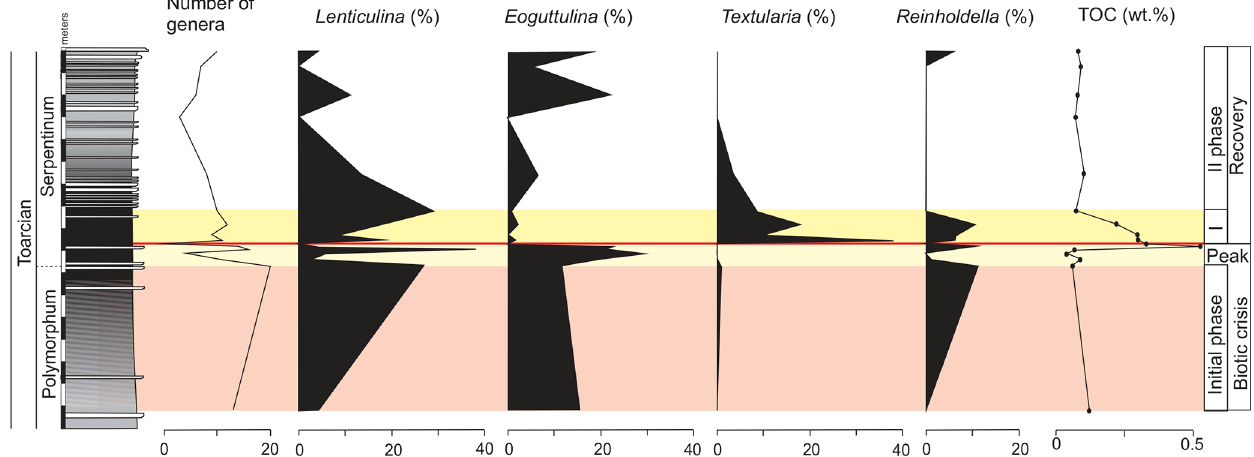
Figure 8. Stratigraphic distribution of the proportions of selected genera of foraminifera in the Polymorphum–Serpentinum Zone boundary compared with diversity and TOC